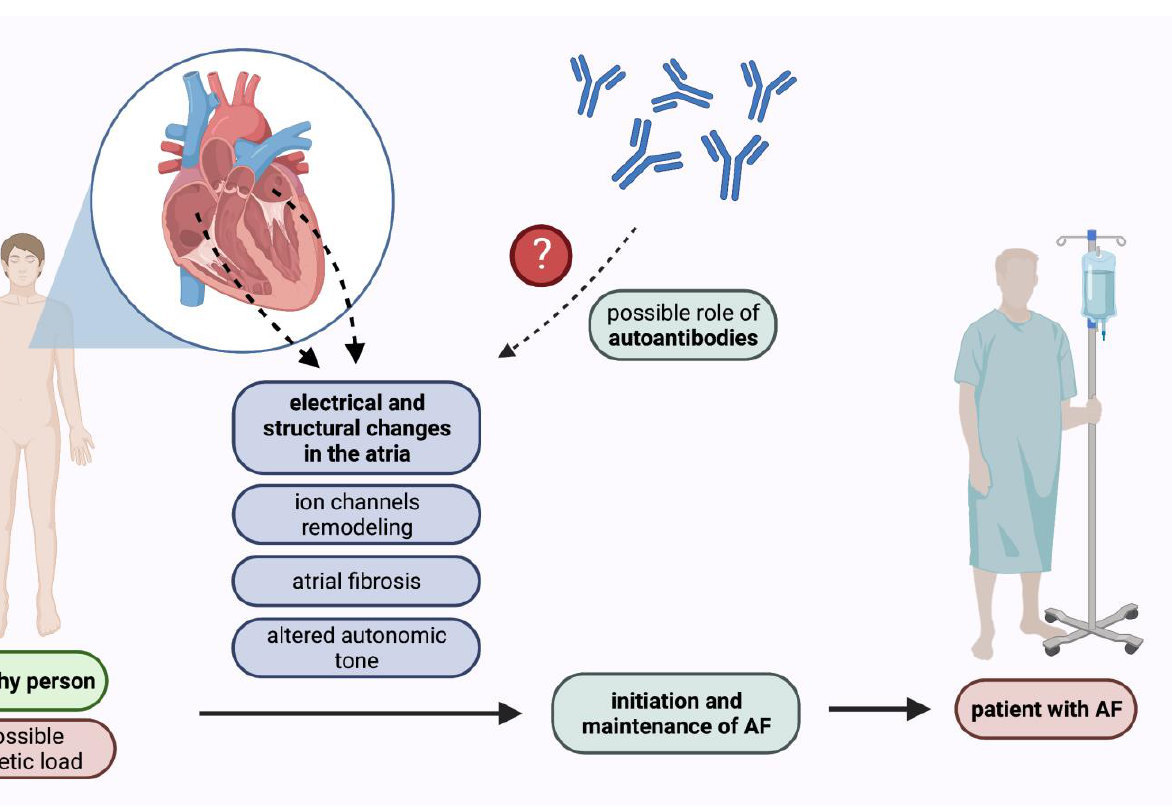
Figure 1. Pathomechanisms of AF initiation and maintenance with the possible role of autoantibodies. AF — atrial fibrillation.